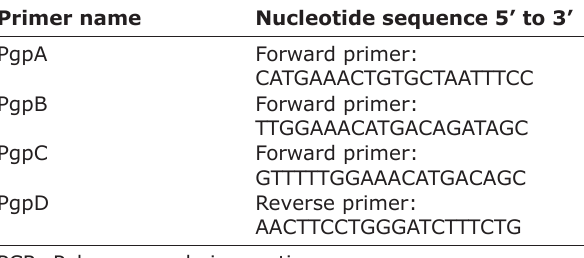
Table-1: Details of the primer sequences used for allele-specific multiplex